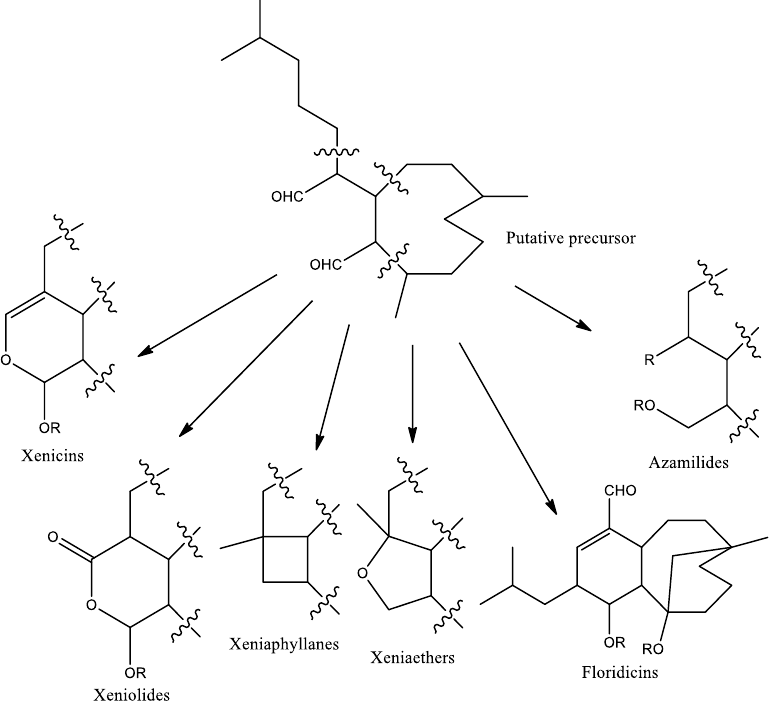
Figure 1. Diversity of chemical skeletons discovered from soft coral genus Xenia .